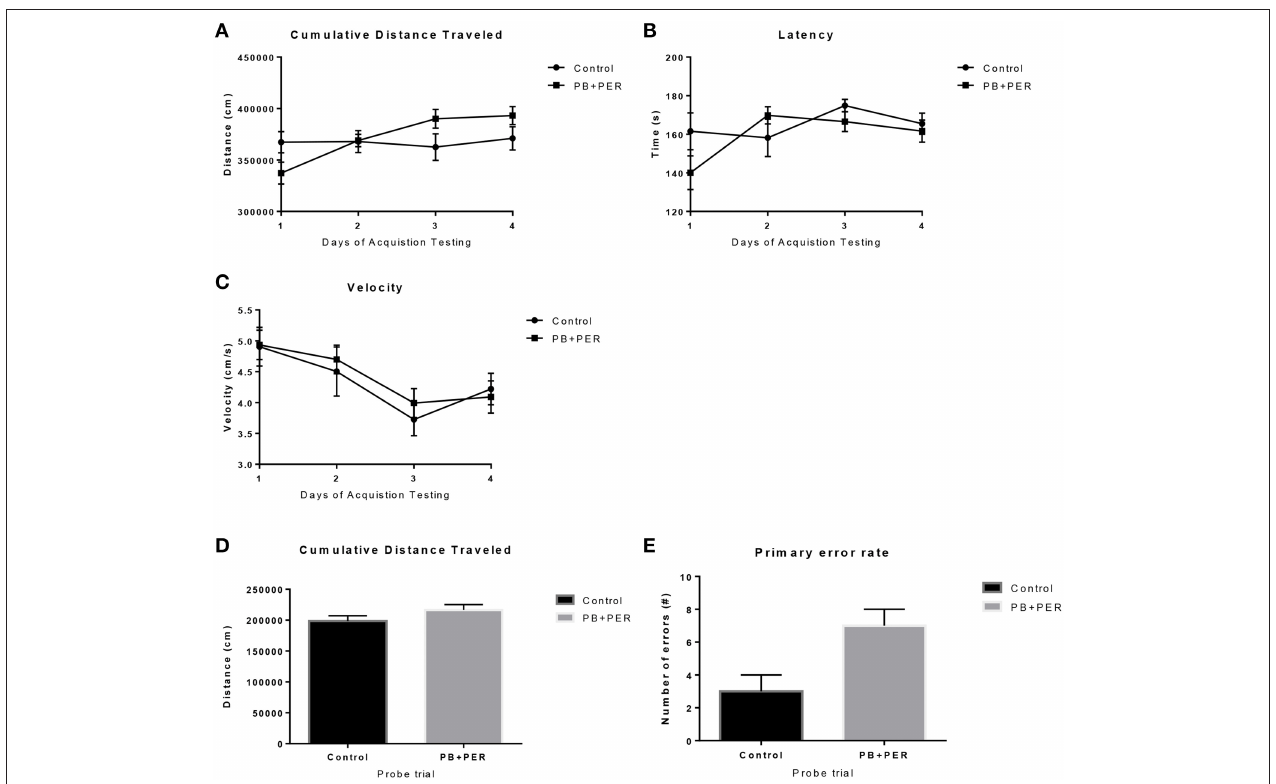
FIGURE 5 | No overall behavioral differences were observed in exposed mice during BM testing at 22.5 months post-exposure to PB + PER. Control and exposed mice behaved similarly when we examined (A) cumulative distance traveled to the target hole, (B) escape latency, and (C) velocity, over a 4-day period. In addition, when the mice were examined 24-h after the last acquisition trial, by a single probe (day 5), the PB + PER exposed mice appeared to travel a longer (D) cumulative distance to reach the TH as compared to controls. When examining the (E) primary error rate (#), PB + PER exposed mice appeared to make more mistakes as compared to controls. Although there were apparent trends, these differences failed to reach statistical